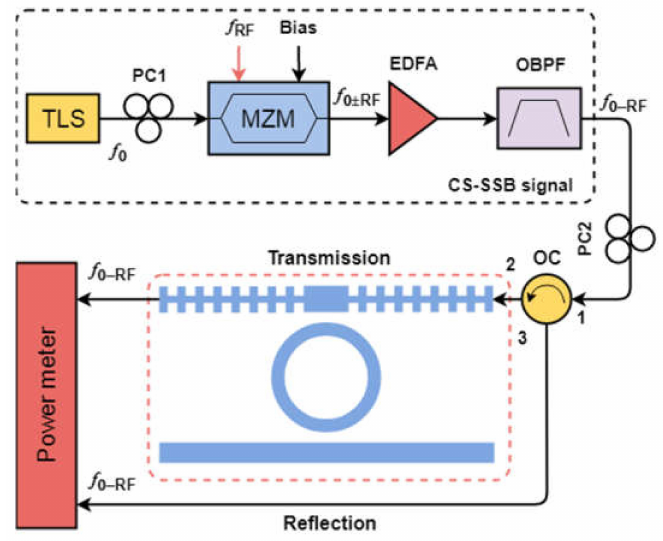
Figure 25. Schematic diagram of a Fano-based IFM system. TLS—Tunable laser source; PC— Polarization controller; MZM—Mach–Zehnder modulator; EDFA—Erbium doped fiber amplifier; OBPF—Optical bandpass filter; OC—Optical circulator (Adapted with permission from Ref [41]. Copyright 2019,